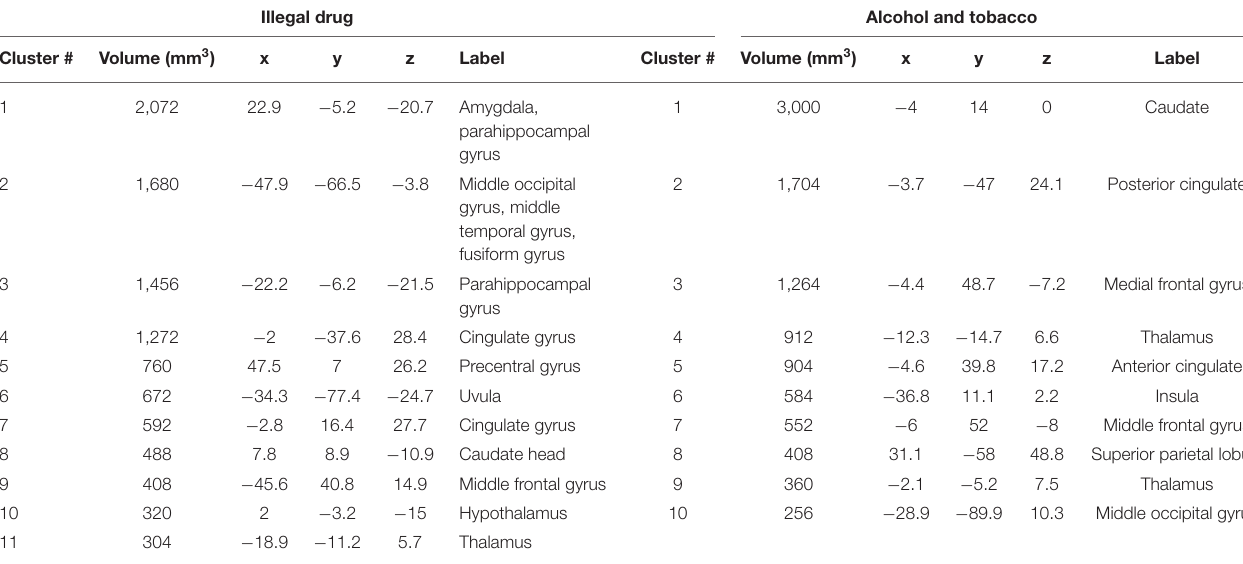
TABLE 2 | Single meta-analysis results.